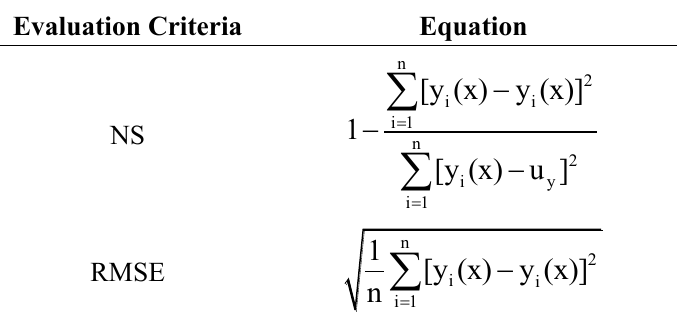
Table 2. Mathematical expressions of performance evaluation